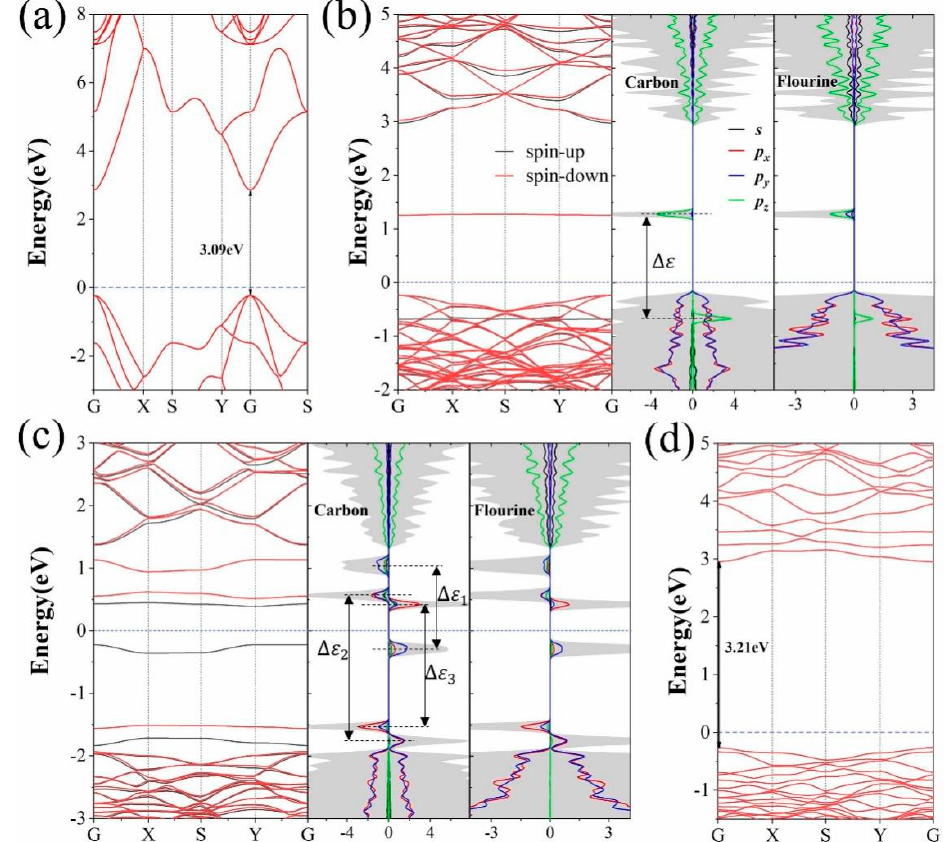
Figure 4. The band structure of ( a ) fluorographene ( b ) V F -fluorographene ( c ) V sCF -fluorographene ( d ) V dCF -fluorographene. For the magnetic structures, the PDOS is shown; the black line represents the spin-up and the red line represents the spin-down; in PDOS, the black, red, blue, and green represent the s , p x , p y , p z orbital of C and F, respectively. The shadow represents the total density of states and the light blue dot represents the fermi-level. ∆𝜀 = 𝜀 ↑ − 𝜀 ↓ , defined as the difference between spin-up and spin-down, is the exchange splitting energy.